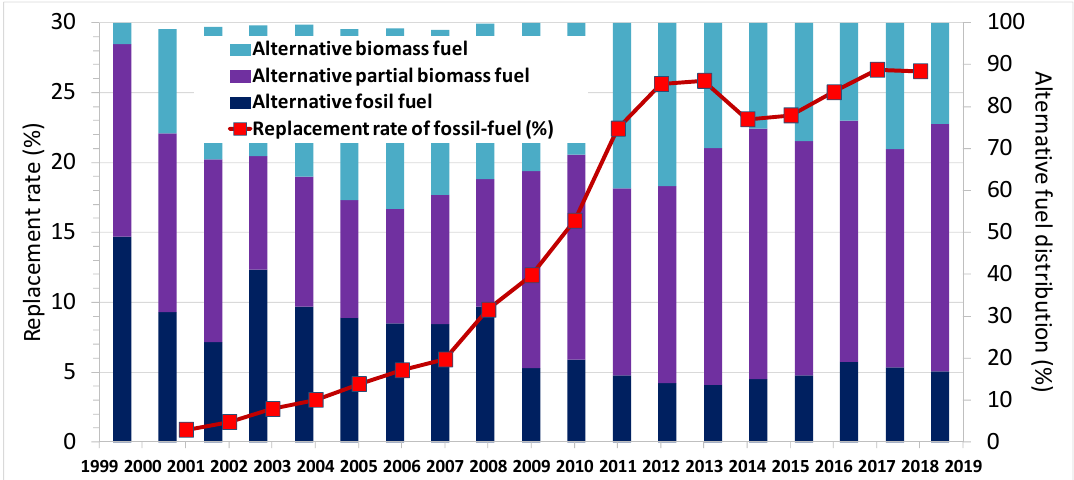
Figure 5. Evolution of the replacement rate of old fossil-fuels and alternative fuel distribution by the Spanish cement industry.